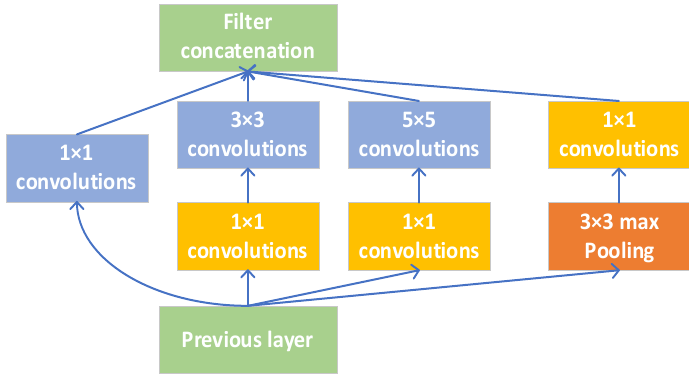
Figure 6. Inception module with dimensionality reduction.